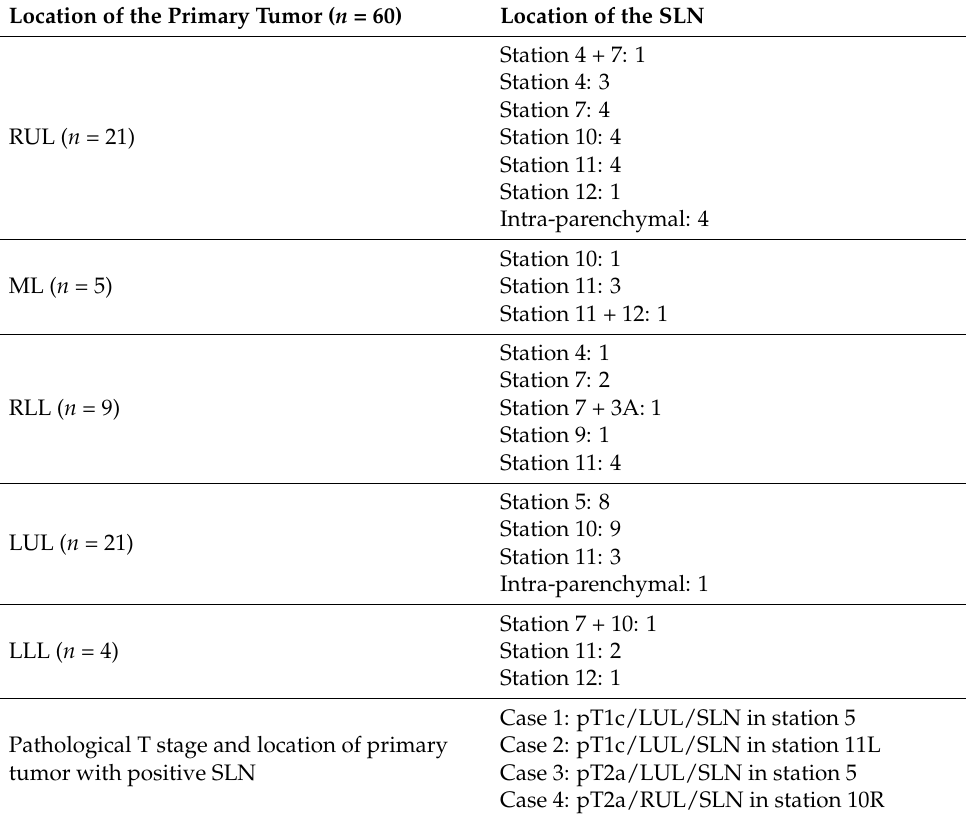
Table 4. Distribution of the different locations of the sentinel lymph node according to the location of the primary